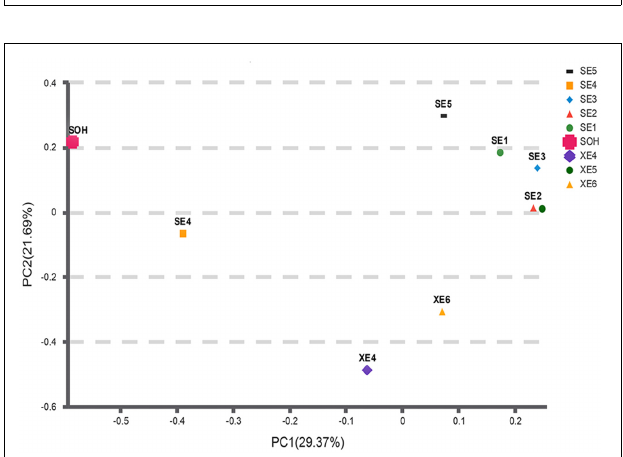
FIGURE 10 | A PCoA scatter plot was calculated with Bray-Curtis. The first two components PC1 and PC2 explain 29.37 and 21.69% of the variations, respectively. Microbial community distribution patterns at a 97%-similarity OTU